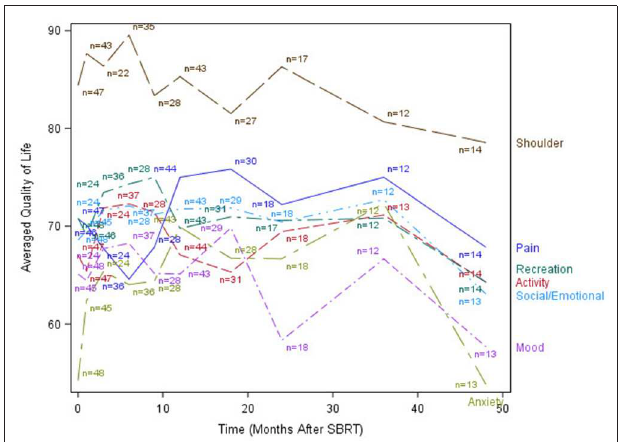
FIGURE 3 | Post-treatment mean patient-reported quality-of-life scores in anxiety, mood, pain, activity, recreation, shoulder, and Social/Emotional domains.